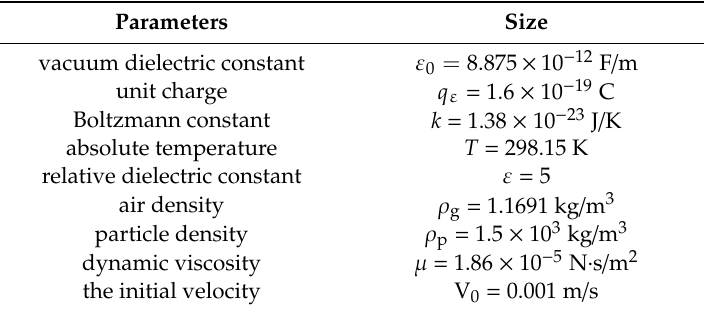
Table 1. Particle separation